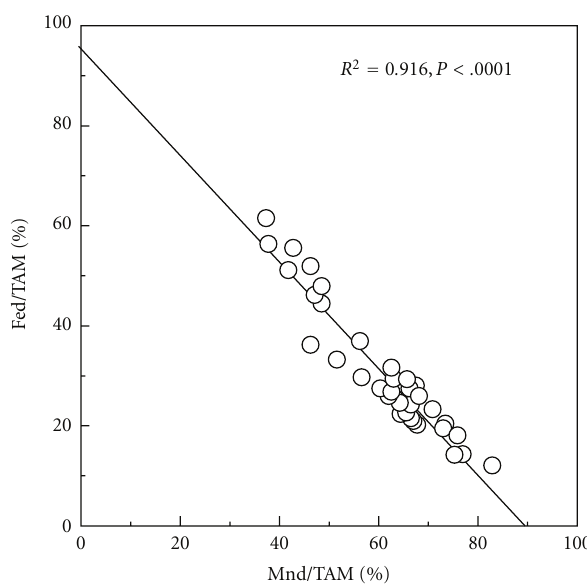
Figure 5: Relationship between Mnd/TAM (%) and Fed/TAM (%). (TAM = total amount of available micronutrients; Mn d + Fe d + Cu d + Zn d + Cd d ).